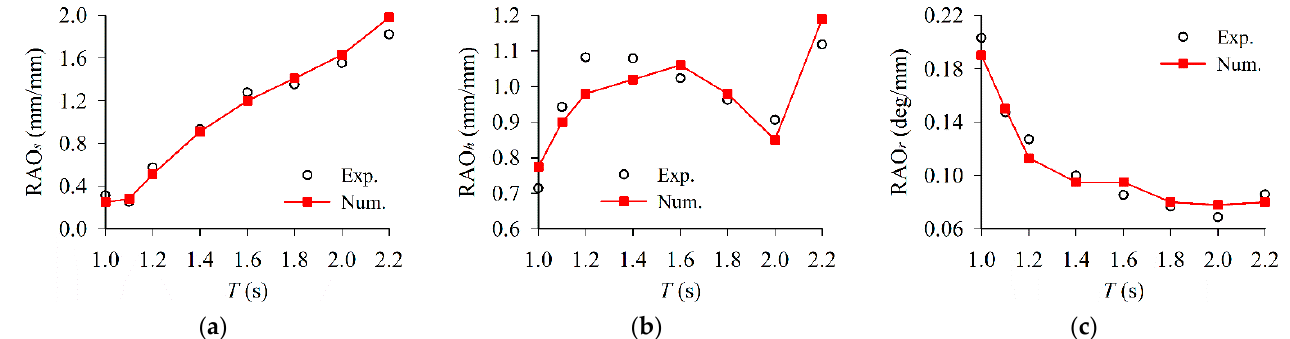
Figure 10. Comparison of the experimental and numerical response amplitude operators of the dual cylindrical floating pontoon: ( a ) Sway motion RAO s ; ( b ) Heave motion RAO h ; ( c ) Roll motion RAO r .